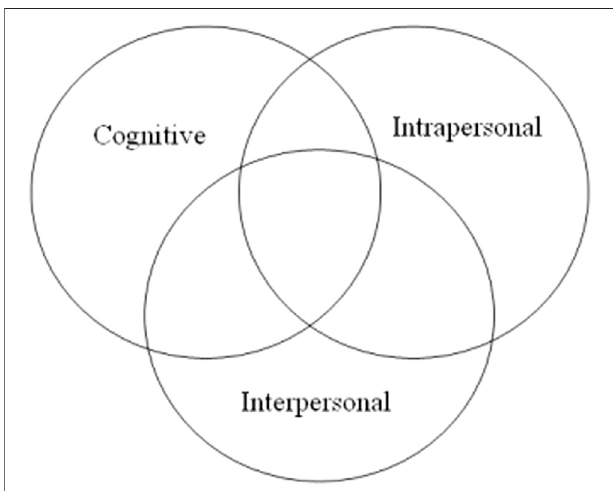
FIGURE 1 | Three dimensions of global